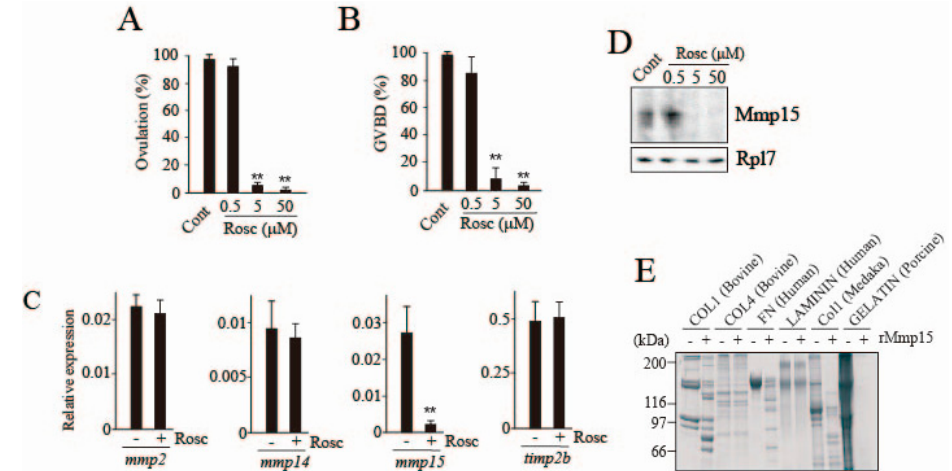
Figure 2. Effects of roscovitine on ovulation, germinal vesicle breakdown (GVBD), and gene expression of ovulation-related Mmps and its intrinsic inhibitor. ( A ) The − 14 h-follicles were incubated in vitro with roscovitine (Rosc) at 0.5, 5, and 50 µ M for 18 h, and the rate of ovulation was determined. Asterisks indicate significance at p < 0.01 (**) compared to follicles incubated without any additives (ANOVA and Dunnett’s post hoc test, N = 5). ( B ) GVBD rate in the follicles was determined. Follicle incubation was conducted as in ( A ), except that the duration of incubation was 14 h. Asterisks indicate a significance at p < 0.01 (**) compared to follicles incubated without any additives (ANOVA and Dunnett’s post hoc test, N = 5). ( C ) The − 14 h-follicles were incubated with or without Rosc for 18 h, and the expression levels of various Mmps and timp2b were determined by real time RT-PCR. Asterisks indicate significance at p < 0.01 (**) ( t -test, N = 5). ( D ) Follicle layers of follicles that had been incubated with or without Rosc for 18 h were analyzed for Mmp15 expression by western blotting.